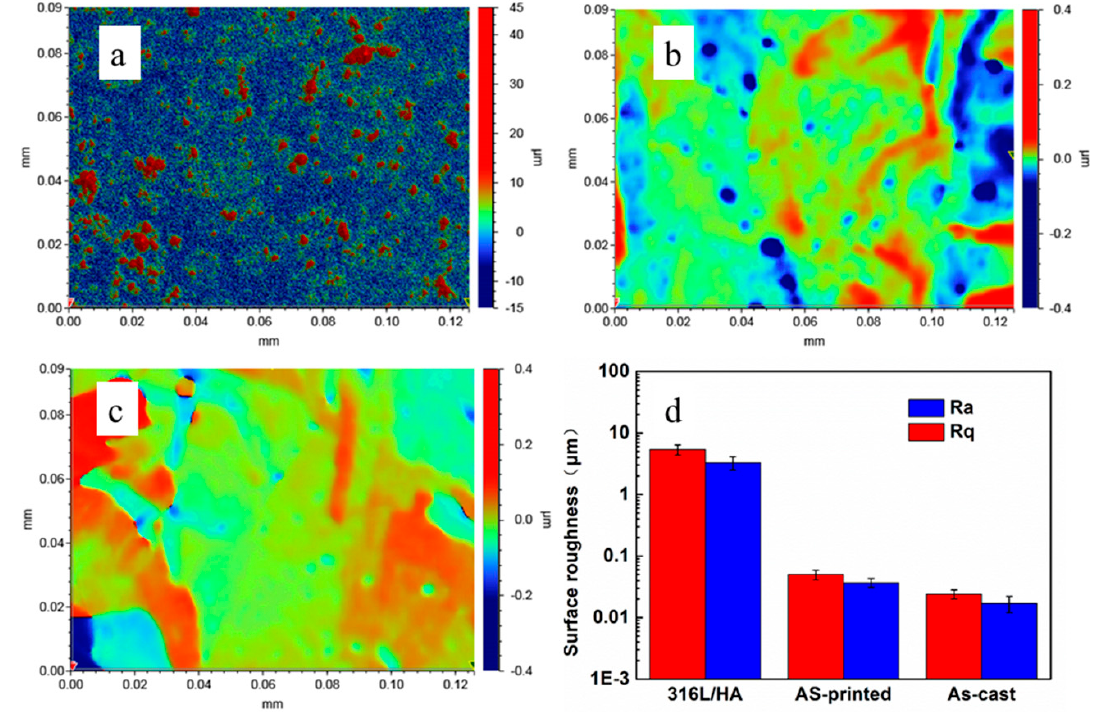
Figure 15. 3-D profiler images of ( a ) 316L/HA, ( b ) as-printed 316L, ( c ) as-cast 316L and ( d ) the average surface roughness.